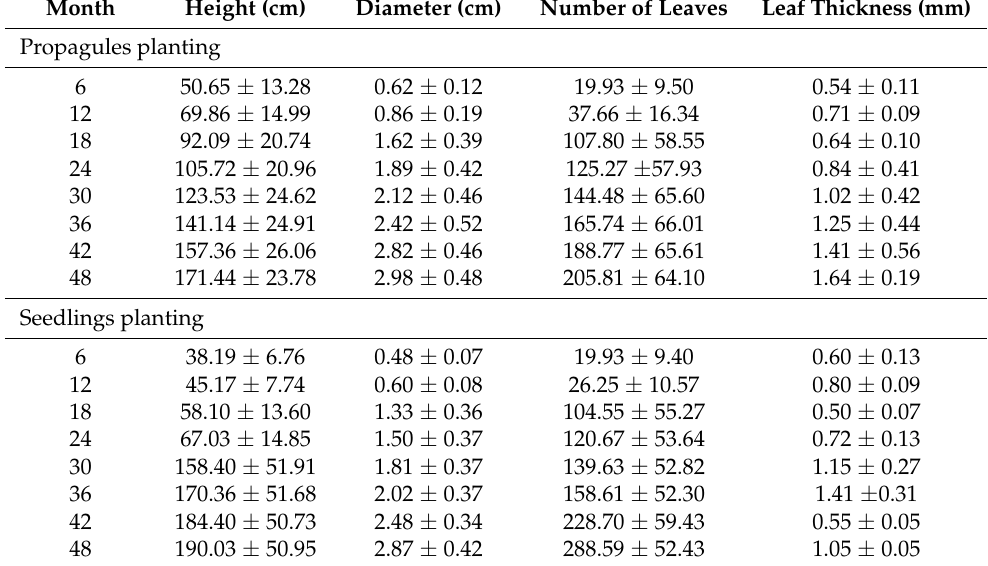
Table 4. Comparison of height, diameter, number of leaves, and leaf thickness between the propagules and seedlings planting methods from 6 to 48 months after